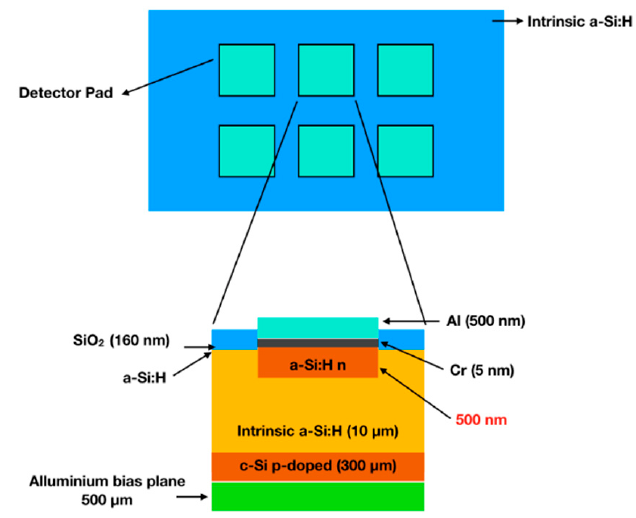
Figure 1. Top and side view of the p-i-n Figure 1. top and side view of the p-i-n diode.